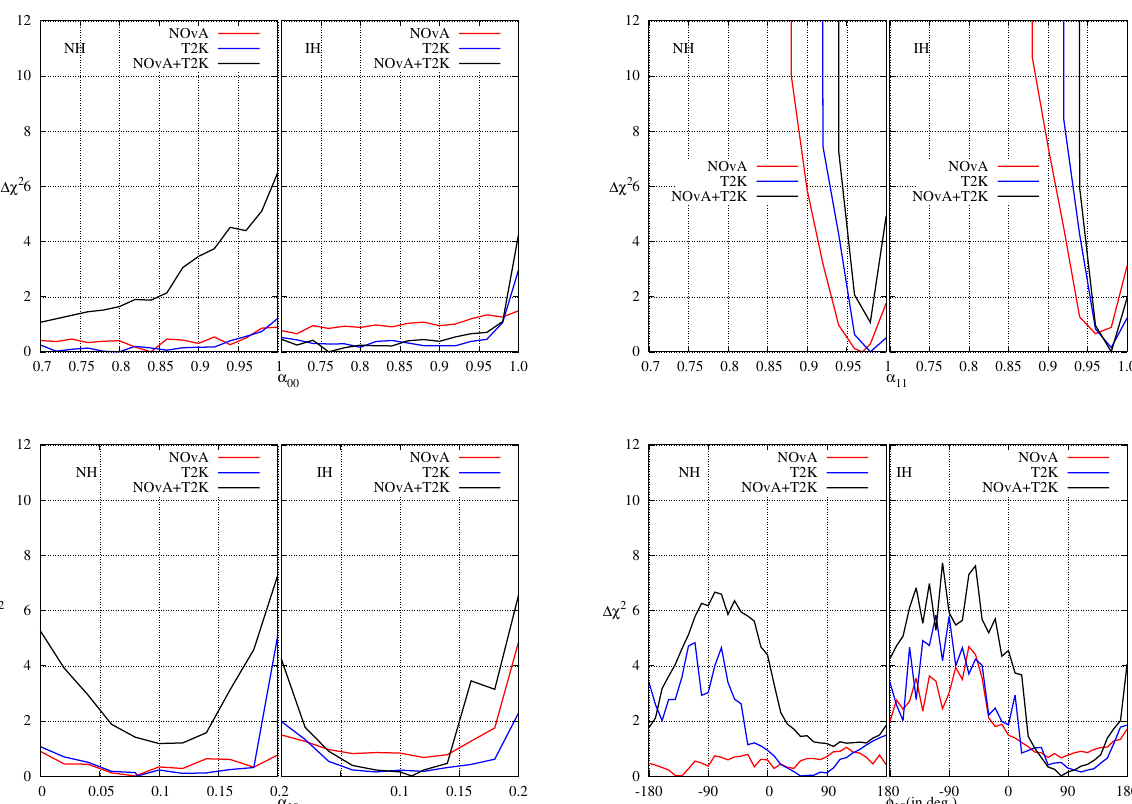
Figure 8. ∆ χ 2 as a function of individual non-unitary parameters after analysing 2020